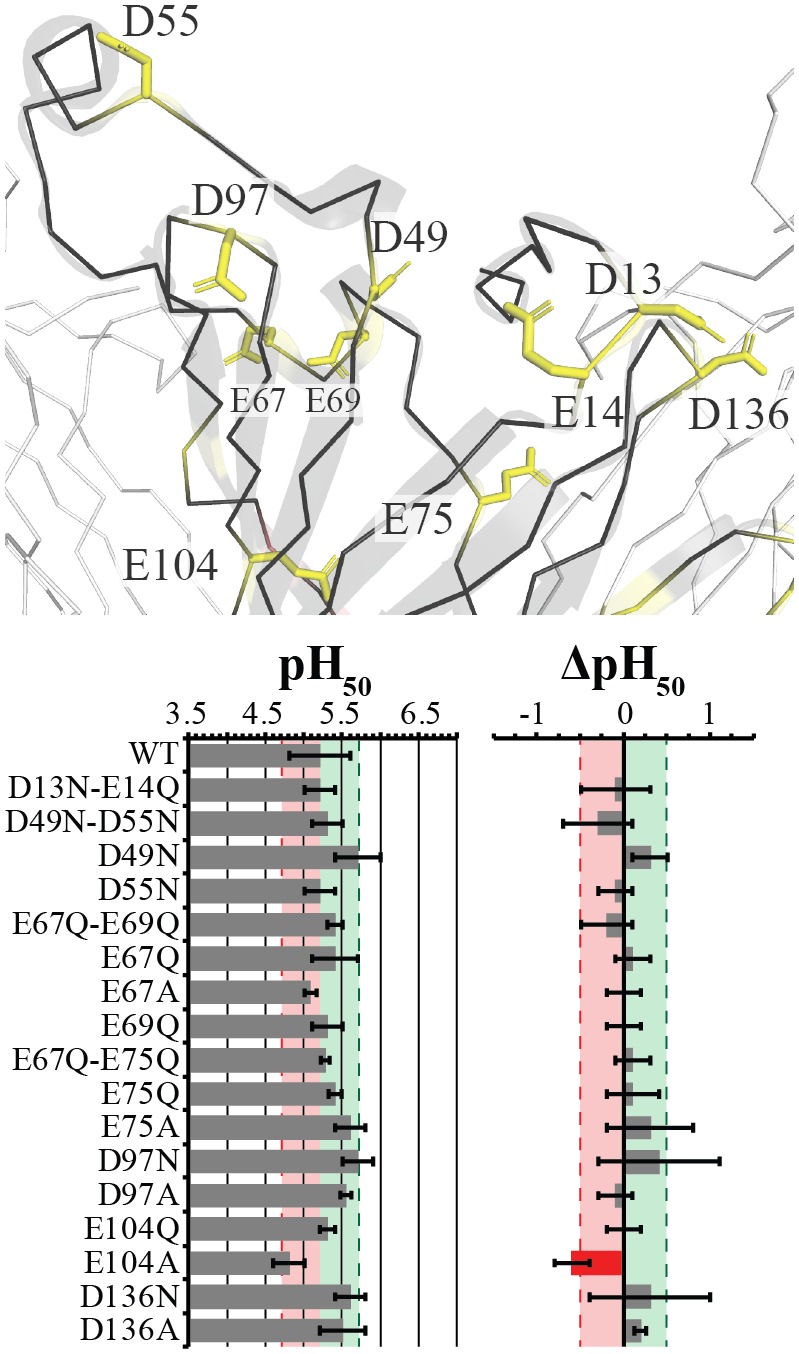
Apical residues do not have an effect on the GLIC pH50.Stick representation of the evaluated Asp and Glu residues are labeled and colored yellow for nonsignificant or weak effects. The main subunit is shown in black with ribbon and cartoon representation, whereas neighboring subunits are represented in white ribbon. Table of the pH50 and ΔpH50 is shown below with mean values ± standard deviation for evaluated mutants with recorded values noted in S1 Table. Light red and green zones with dashed lines represent the respective ½ log decreases and increases from Wt. Values outside this region are color coded for ease of interpretation with red and green respectively. GLIC, G. violaceus ligand-gated ion channel; Wt, wild-type.